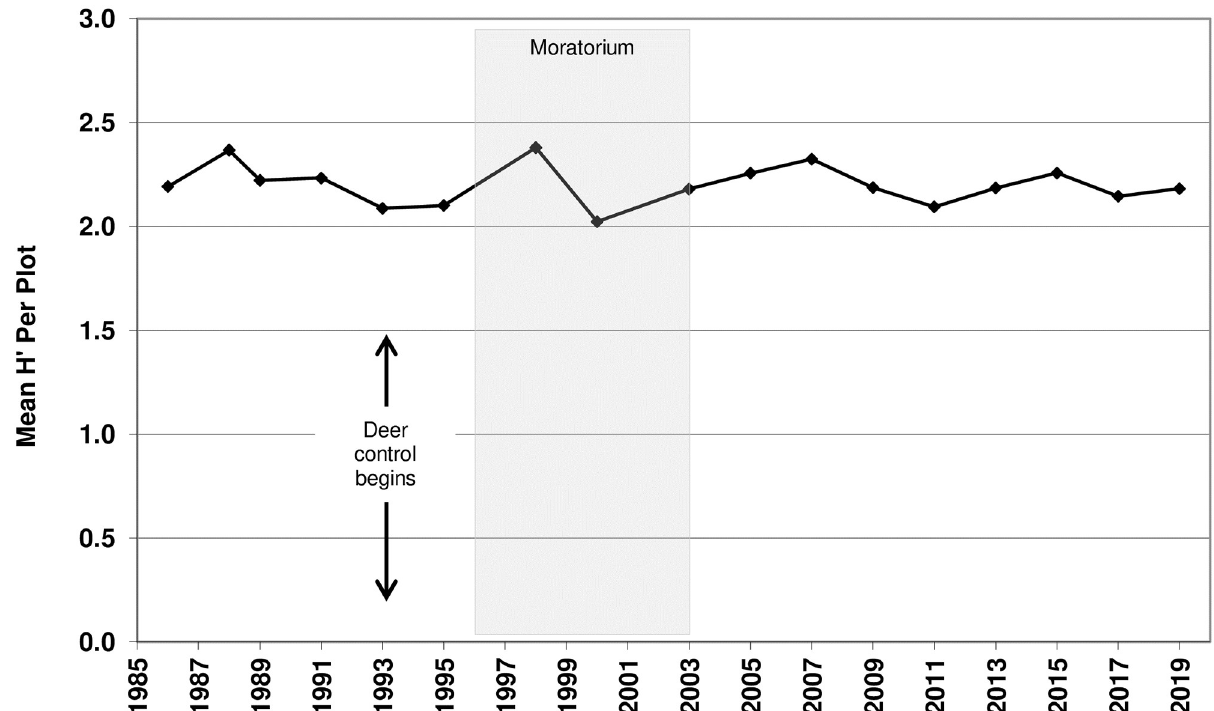
Fig 5. Mean Shannon-Weiner Diversity Index (H’) per plot. Time series analysis used the mean value for each year sampled. Arrows represent the onset of deer culling, which continued thereafter. Shaded area represents the vegetation management moratorium years.